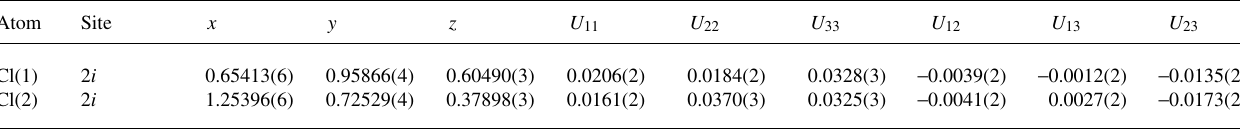
Table 3. Atomic coordinates and displacement parameters (in Å 2 )